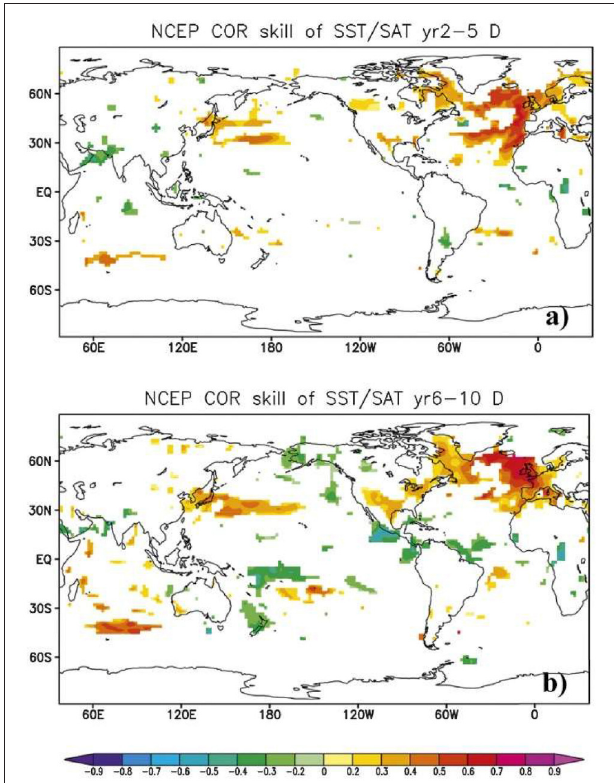
FIGURE 3 | Decadal-scale sea surface temperature (SST) forecast skill. Skill is shown as the temperature predictability beyond the global warming trend for the ECHAM5/Max Planck Institute Ocean Model (MPI-OM) coupled model with initial conditions provided by the NCEP reanalysis. Correlation coefficients between linearly-detrended observations and forecasts are shown for forecast lead times of (a) 2–5 years and (b) 6–10 years. Only the significant correlations (at the 5% level) are plotted. Modified from ( Matei et al., 2012b). © 2012 American Meteorological Society. Used with